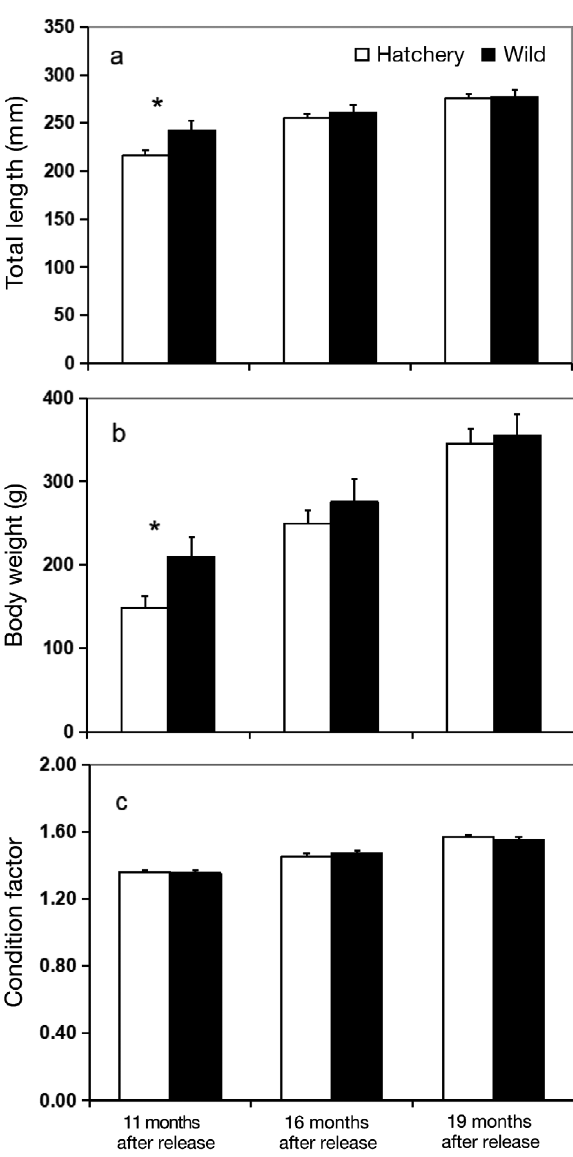
Fig. 3. Comparison of (a) total length, (b) body weight and (c) condition factor between hatchery mandarin fish and wild mandarin fish at the same age in 3 surveys 11, 16 and 19 mo after release. Values are means (±SE). *Significant differences between hatchery and wild fish (p <